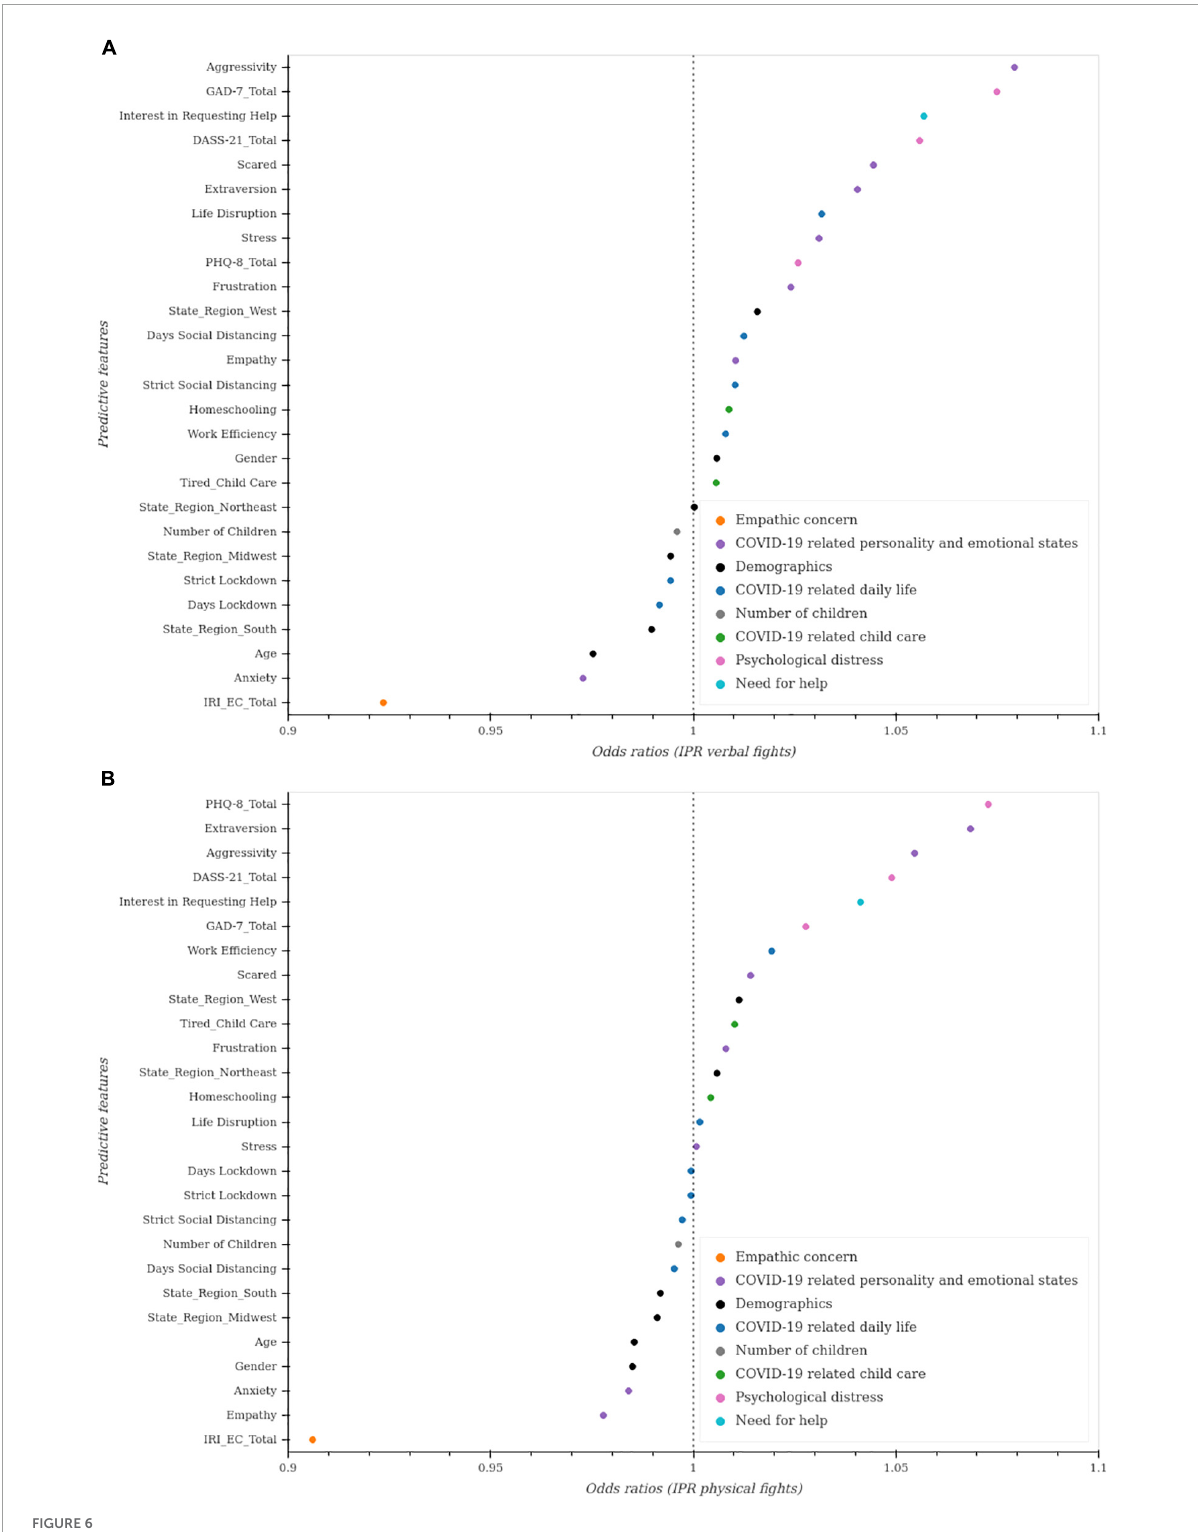
FIGURE6 Regularized regression model predicting intimate partner verbal fights (Time 3) (A) and intimate partner physical fights (Time 3) (B)